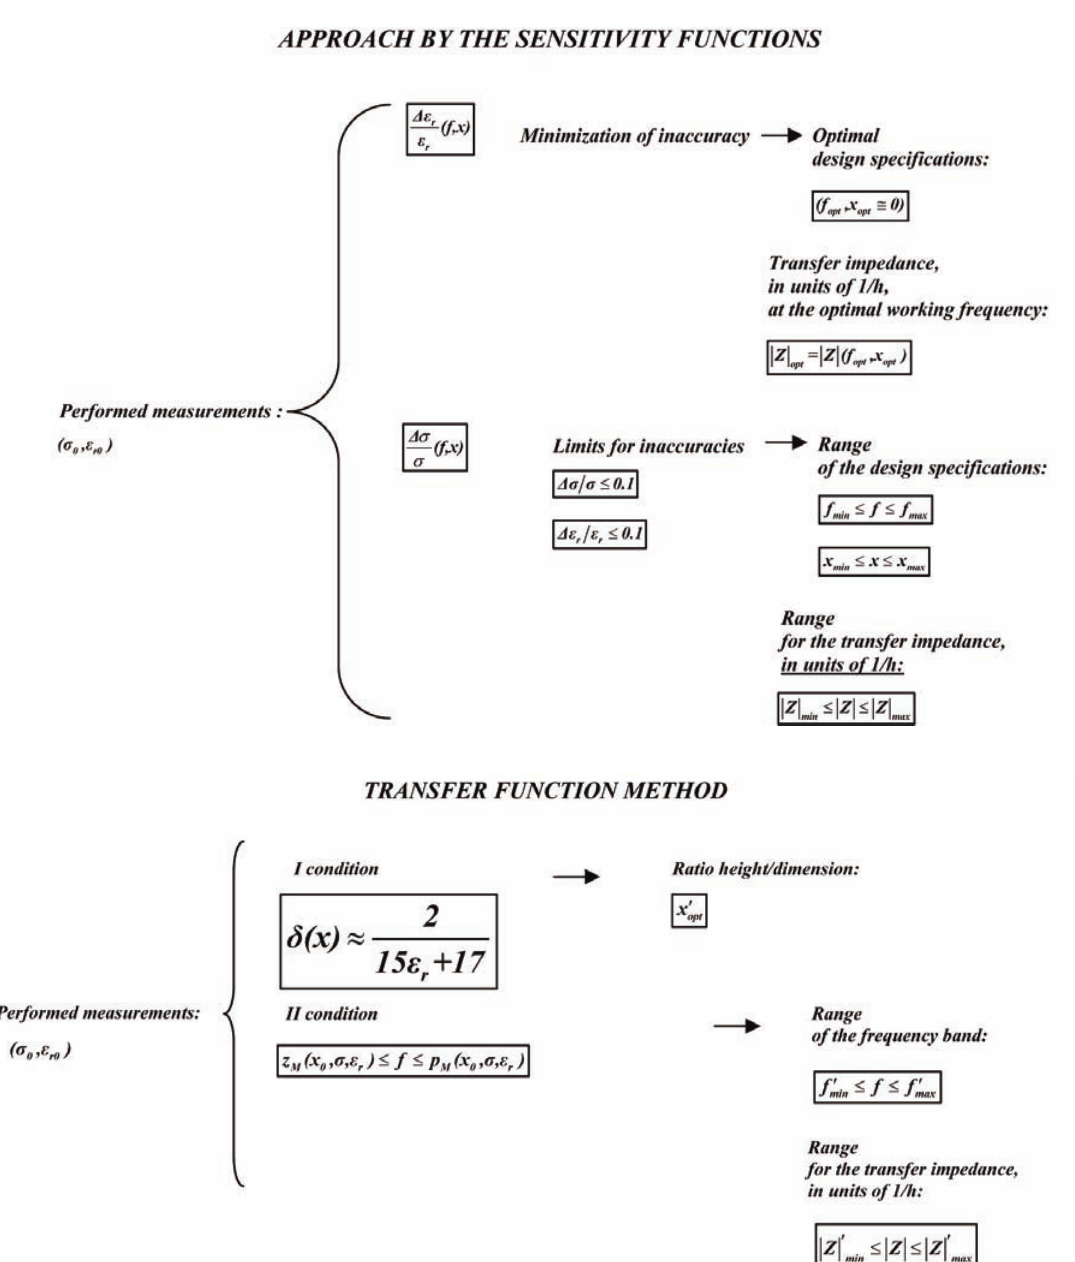
Figure 6. Conceptual schemes for numerical simulations to design the characteristic geometrical dimensions and the frequency band, limiting inaccuracies in the measurements of the quadrupole probe in capacitive contact with selected materials as non-saturated concretes, in the hypothesis that D | Z |/| Z |= DU / U = 10 −3 Z Z